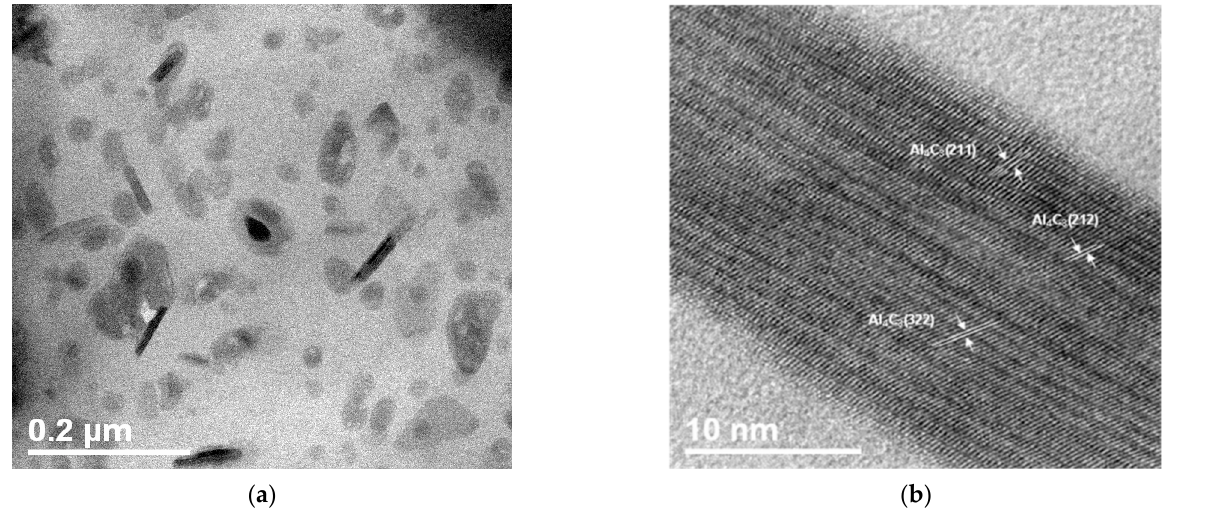
Figure 8. ( a ) HRTEM image of 300/1s sample. ( b ) Close view of a particle.